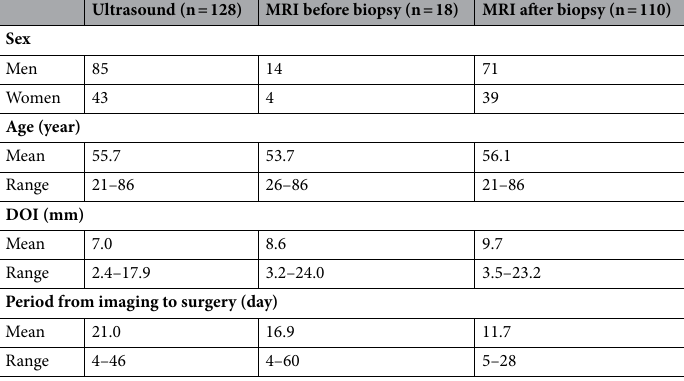
Table 1. Summary of patients’ data. DOI depth of invasion.